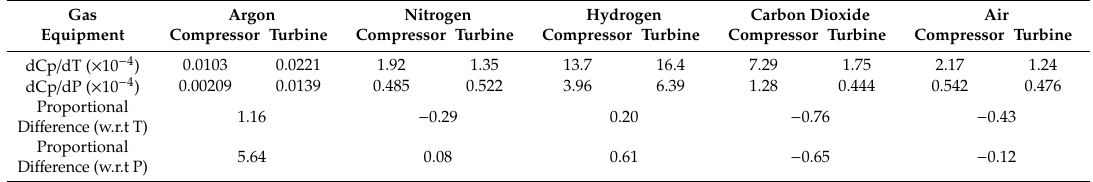
Table 2. Heat capacity slopes with respect to temperature and pressure in the compressor and turbine for di ff erent gases and their proportional di ff